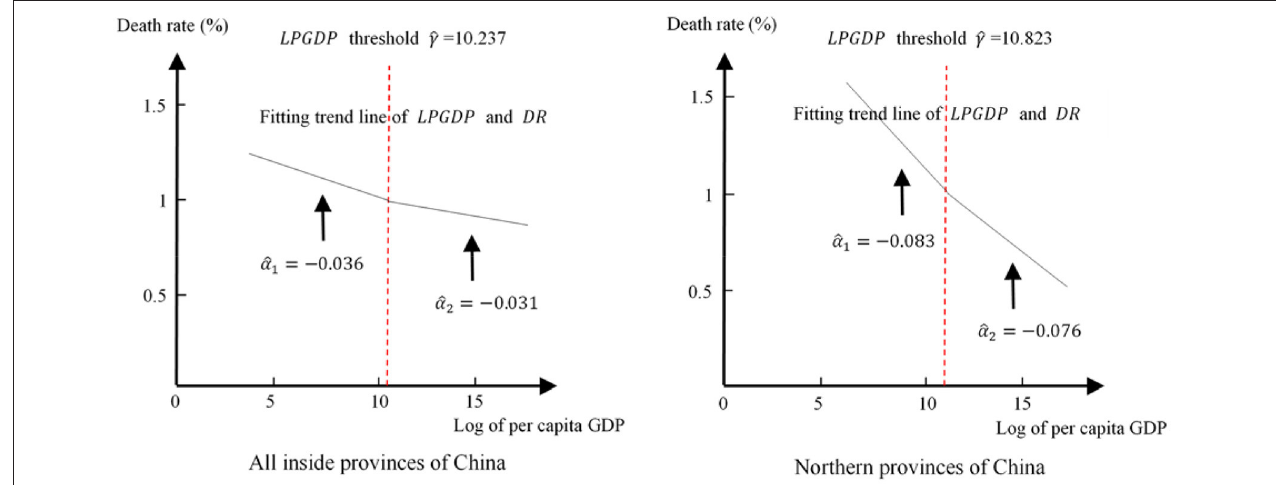
FIGURE 1 | Simulation of the relationship between urbanization and population health.